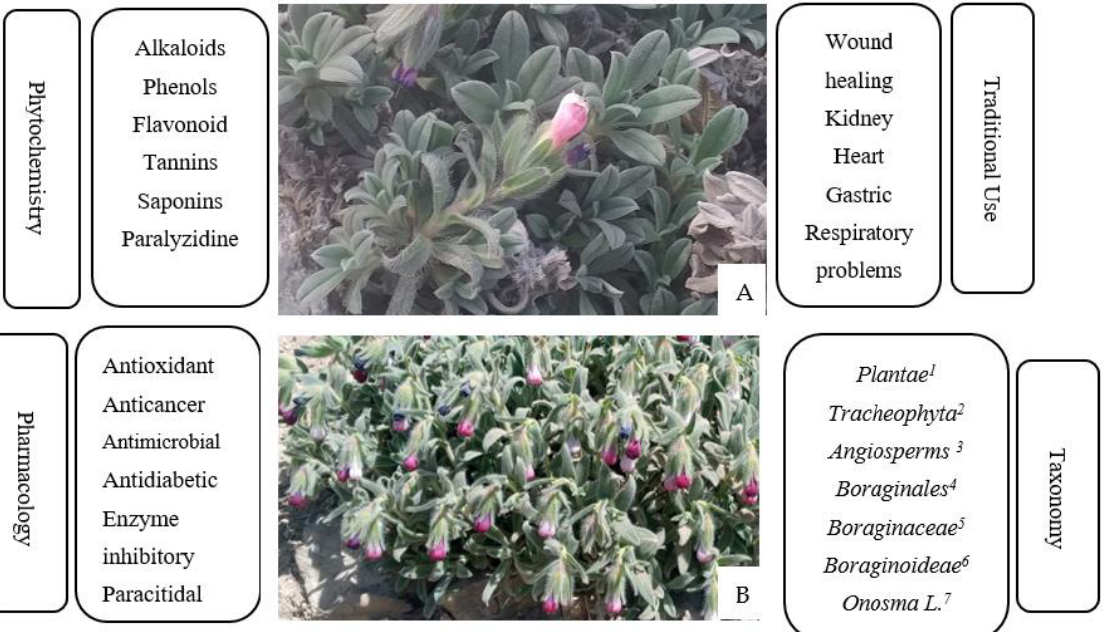
Figure 2. Chemical profile and pharmacological activities of the Onosma species (( A ) O. mutabilis , ( B ): O. Alborosea). 1 : Kingdom, 2 : Phylum, 3 : Class, 4 : Order, 5 : Family, 6 : Subfamily, 7 : Genus.